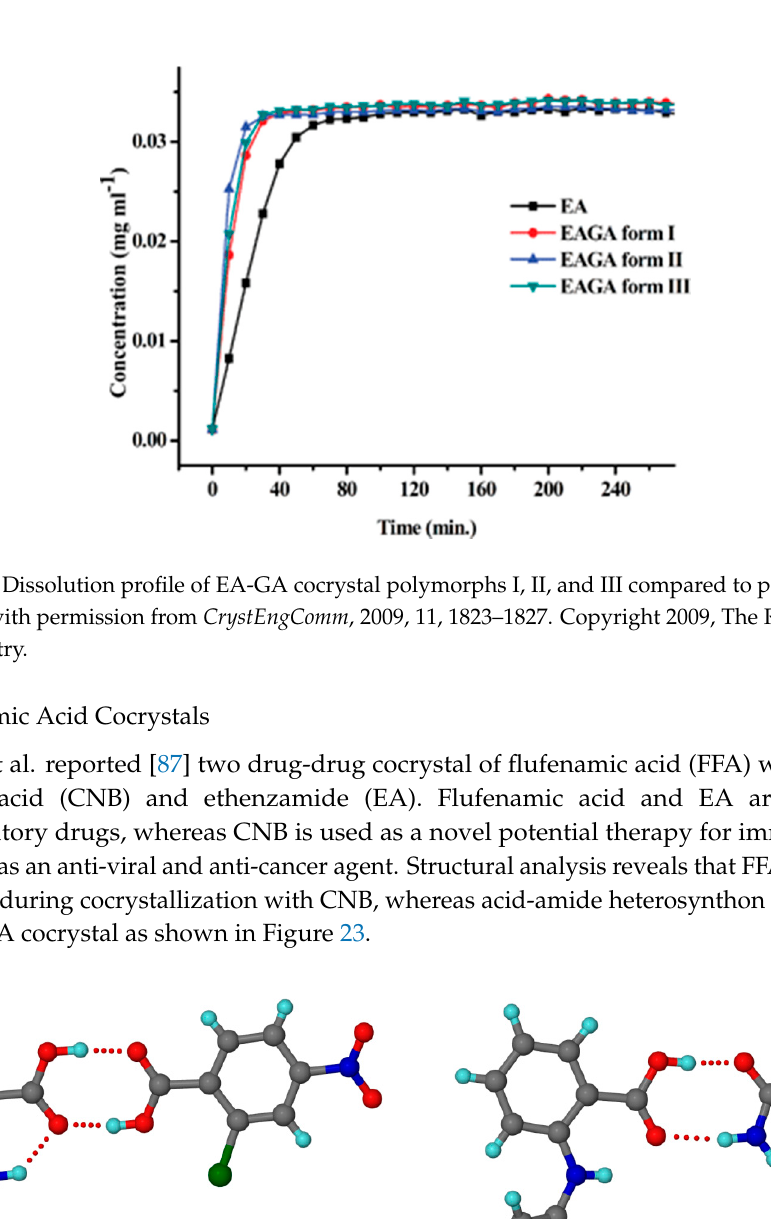
Figure 21. ( a ) A hydrogen bonded linear tape in form II crystal structure. ( b ) A hydrogen bonded tetrameric motif in EA-GA form III crystal structure. Adapted with permission from CrystEngComm ,